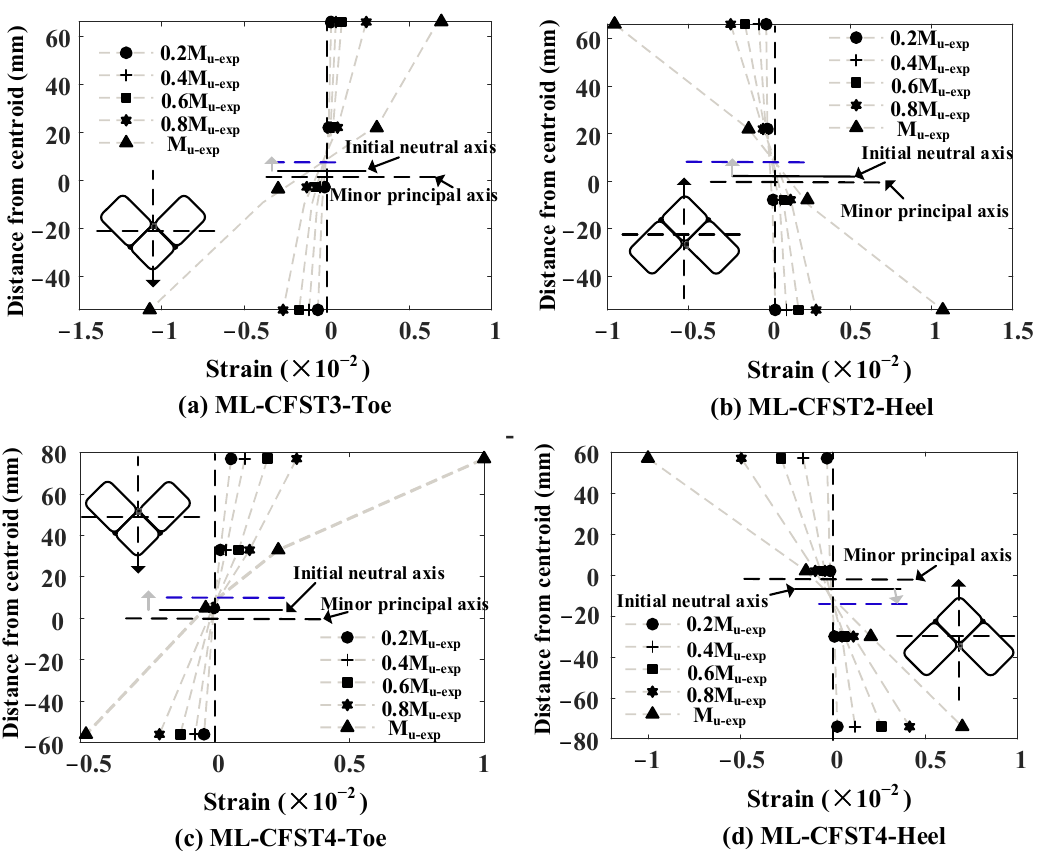
Figure 17. Strain distributions of typical specimens: ( a ) ML-CFST3-Toe; ( b ) ML-CFST2-Heel; ( c ) ML-CFST4-Toe; ( d ) ML-CFST4-Heel.